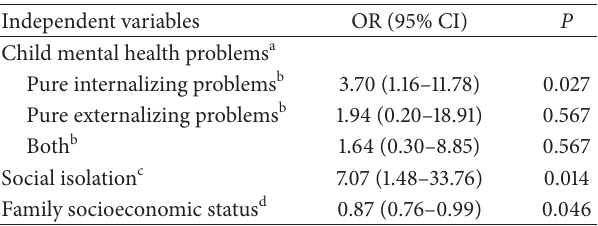
Table 4: Logistic regression model to estimate adjusted odds of correlates of lifetime paid work among children aged 9–13